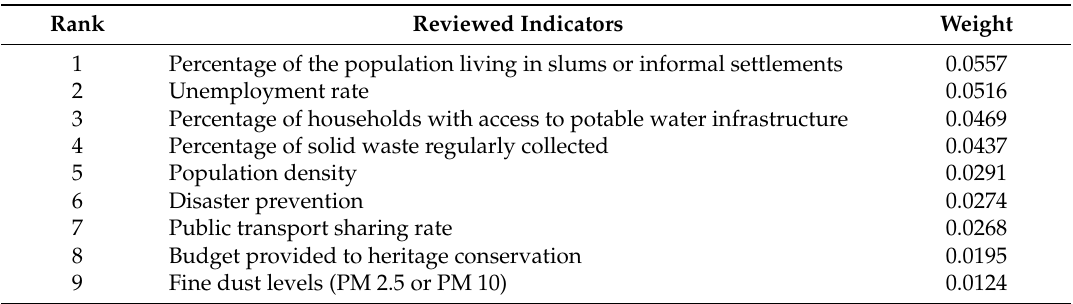
Table 6. Nine UN SDG 11 indicators prioritized for applying to Cambodia based on the priority weights of the correlated consensus indicators.